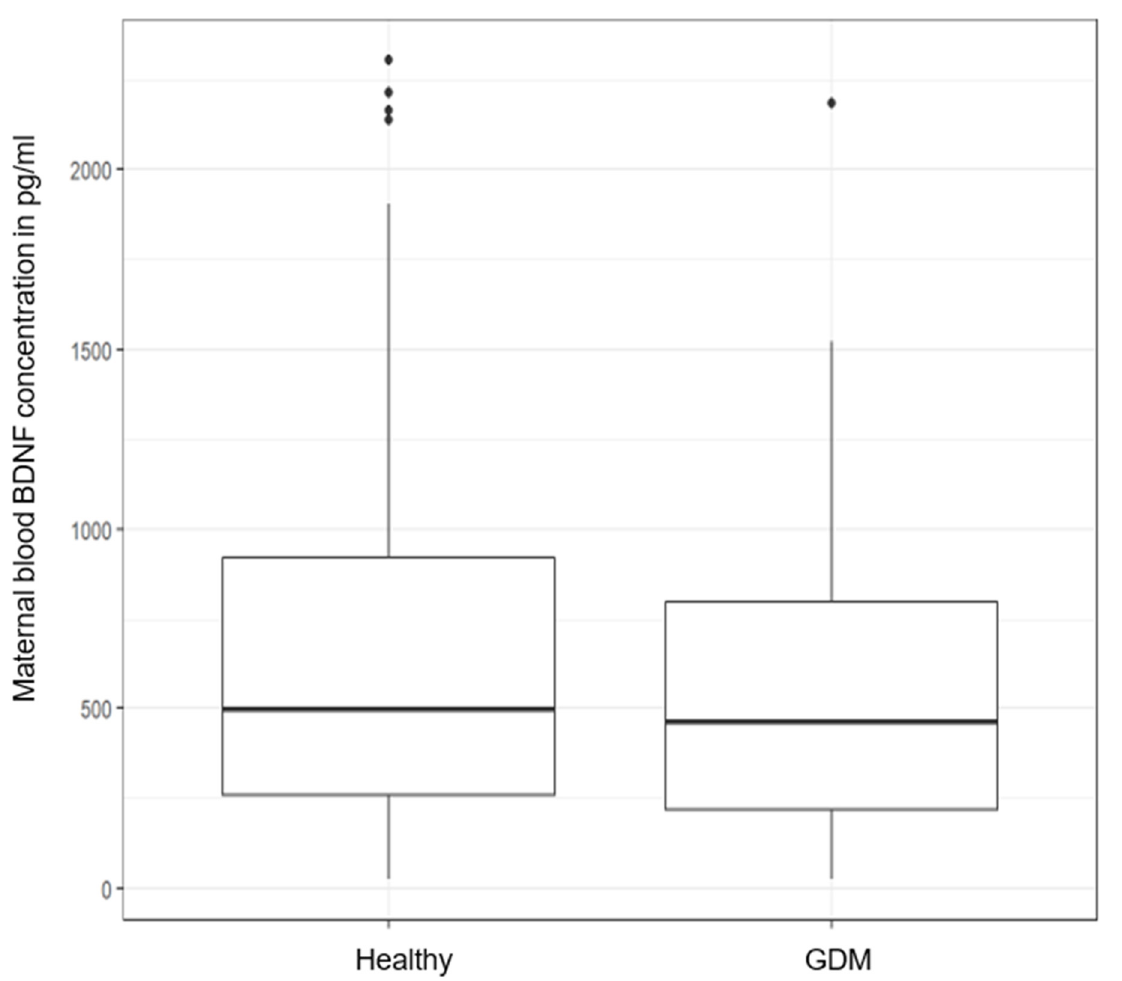
Figure 3. Maternal BDNF concentration (pg/mL) in cases with GDM and metabolically healthy controls ( p = 0.34).